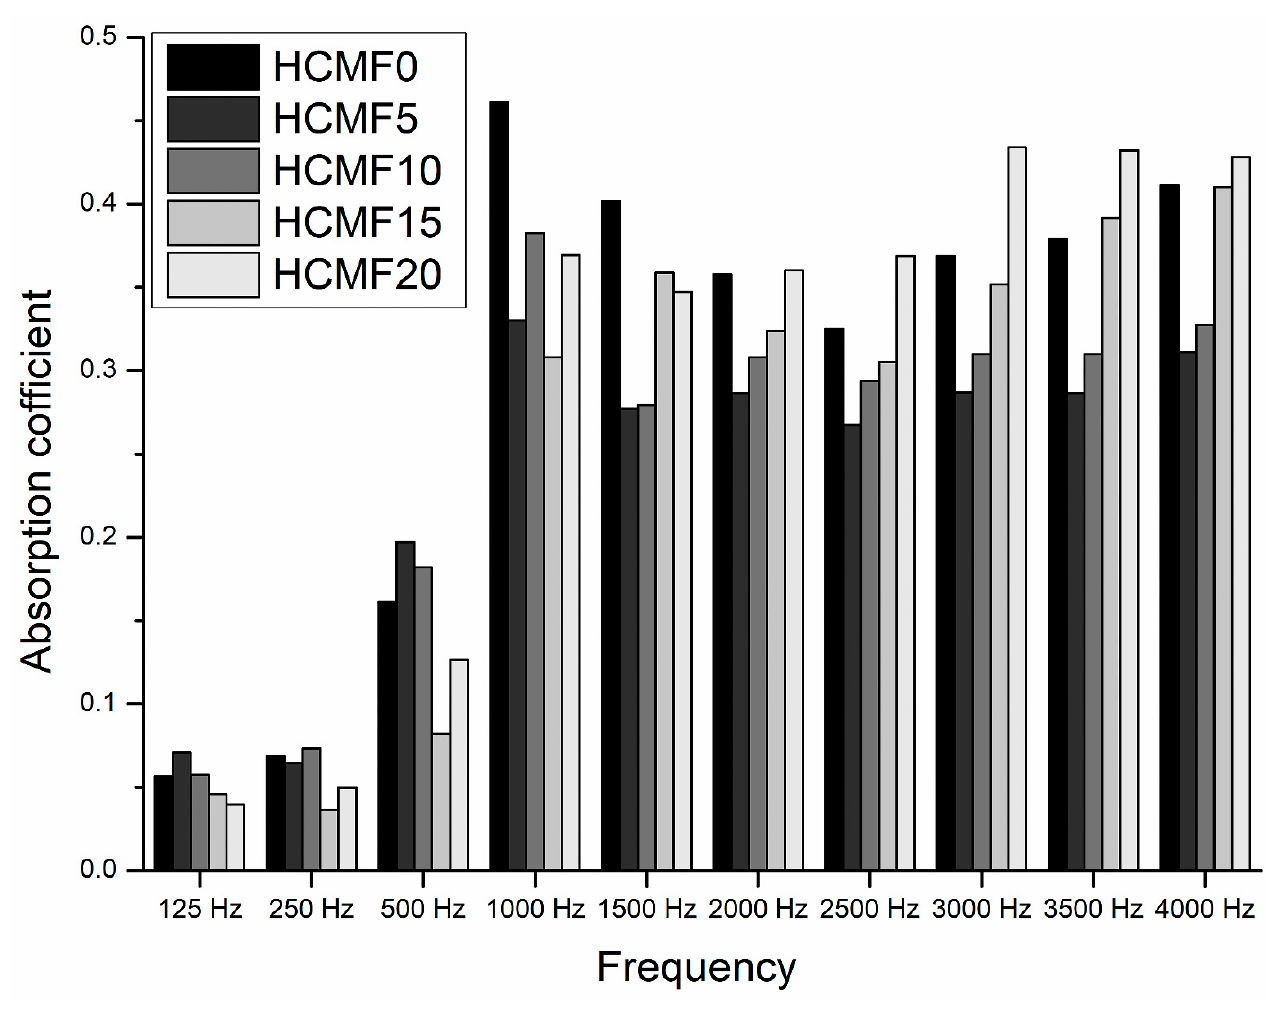
Figure 12. Sound absorption coefficient of HCMF composites as related to the HCM content.